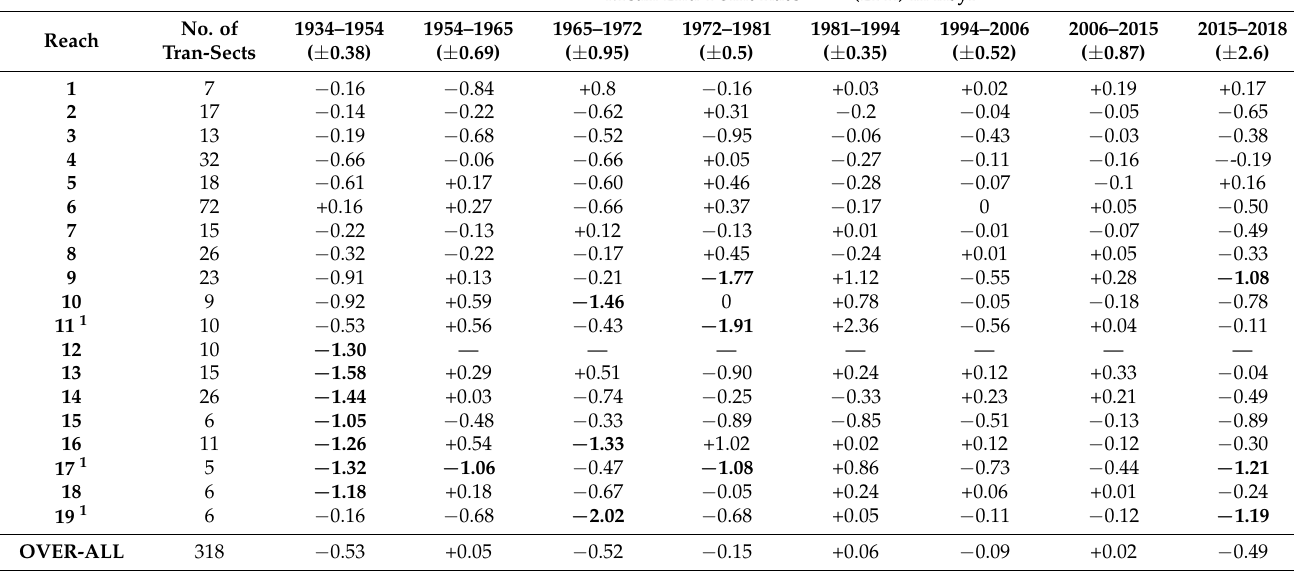
Table 7. Short-term coastline change analysis results. Digital Shoreline Analysis System short-term analyses that included the following aerial photographs: 1934, 1954, 1965, 1972, 1981, 1994, 2006, 2015 and 2018; ran at the smallest time increments with years available. Transects were cast at 20 m intervals. Results include the end-point rate (EPR) for each reach with calculated uncertainties for each